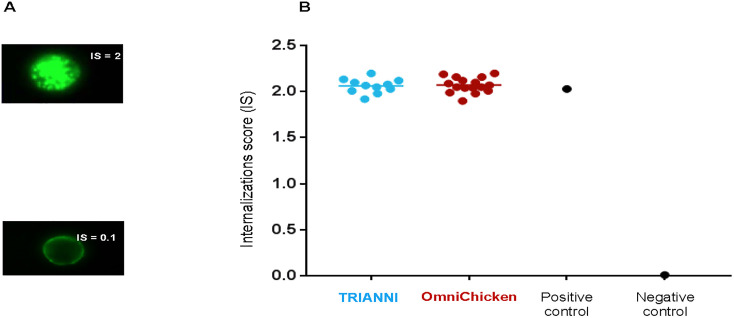
Anti-LAMP1 antibodies are readily internalized by LAMP1-expressing HCT116 cells.(A) Representative images of tumor cells that internalized antibodies with high (IS = 2), and no internalization (IS = 0.1). Images shown are from antibodies unrelated to this study. (B) Internalization scores of anti-LAMP1 mAbs derived from the TRIANNI (blue circles) and OmniChicken (brown circles) platforms and positive and negative controls on LAMP1-expressing HCT116 cells. Horizontal lines indicate means.